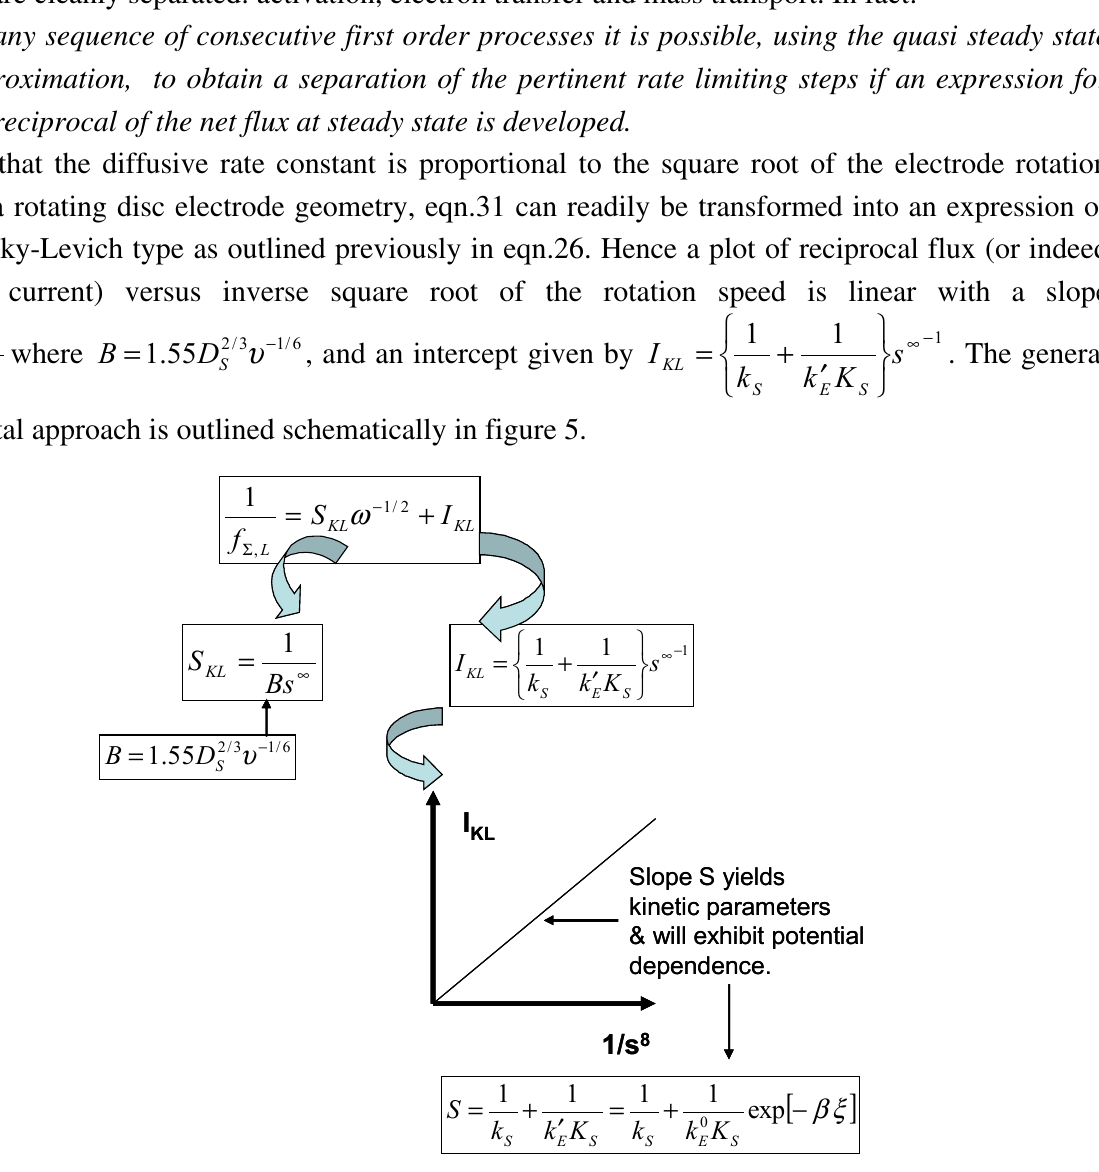
Figure 5. Data analysis protocol for the generalized Koutecky-Levich